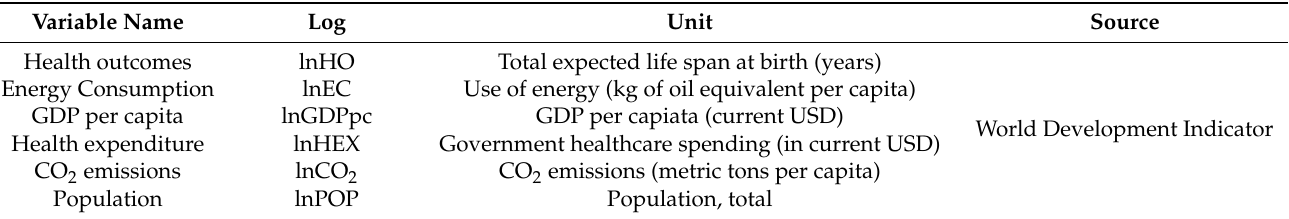
Table 1. List of all variables.